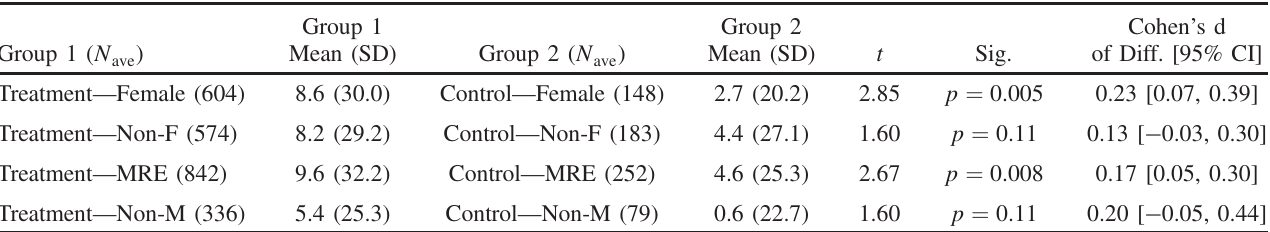
TABLE V. Summary of unpaired t tests for Study 2. Each row represents the independent samples Welch ’ s t test after combining 100 multiply imputed datasets according to Rubin ’ s